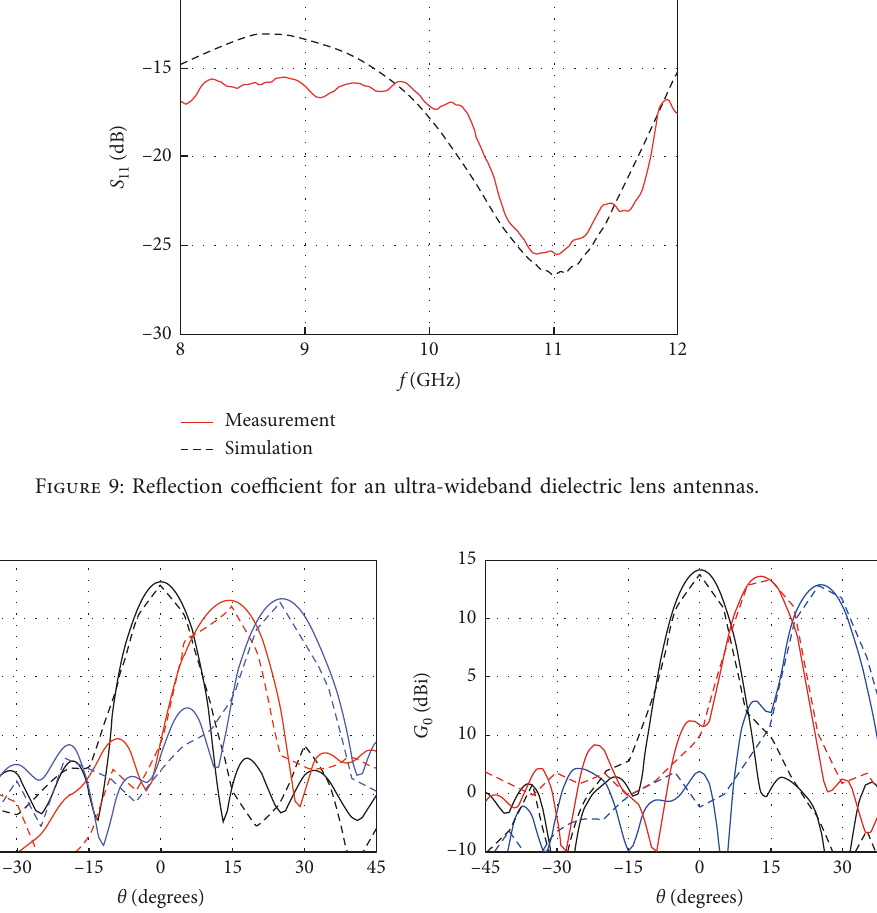
1 simulation, A 1 measurement,